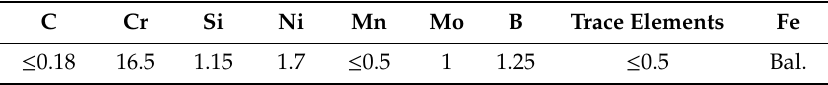
Table 1. Chemical composition of homemade stainless steel powder (wt. %).